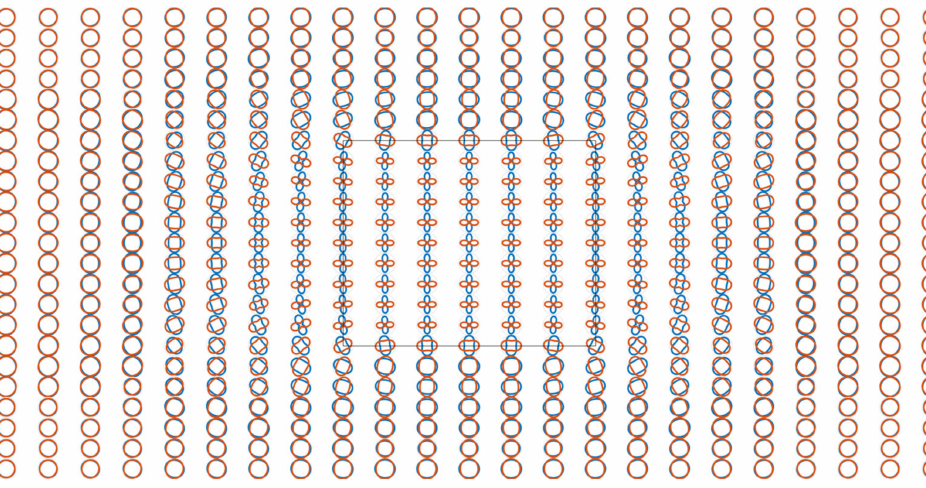
Figure 8. Polar plots of modified COMMEMI 3D-1A model for a frequency of 0.57